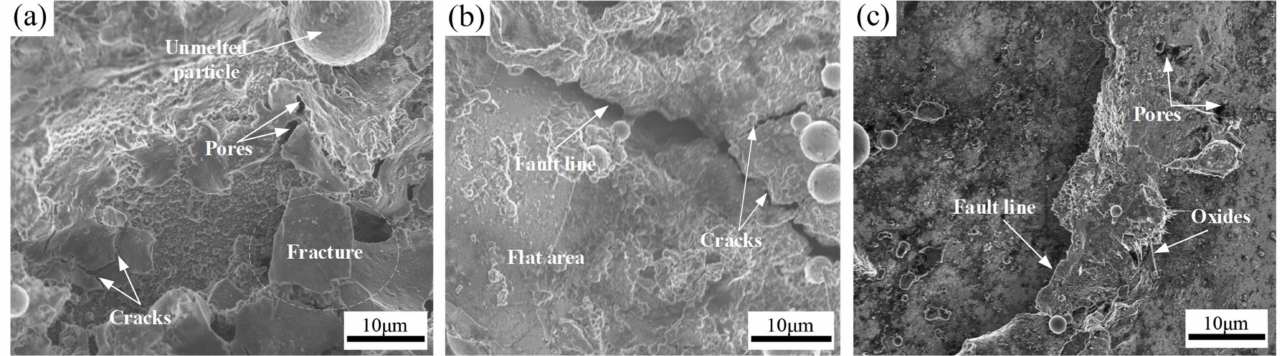
Figure 4. SEM micrographs in secondary electron (SE) mode of adhesive failure for ( a ) as-sprayed coating, ( b ) coating annealed at 300 ◦ C, and ( c ) cohesive failure for coating annealed at 600 ◦